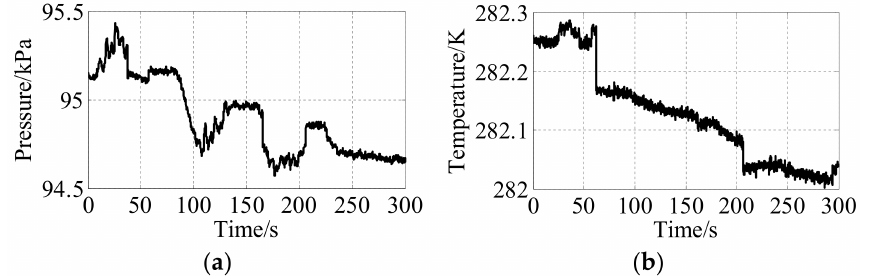
Figure 13. Inlet conditions of air source I. ( a ) Pressure conditions of air source I; ( b ) Temperature conditions of air source I.